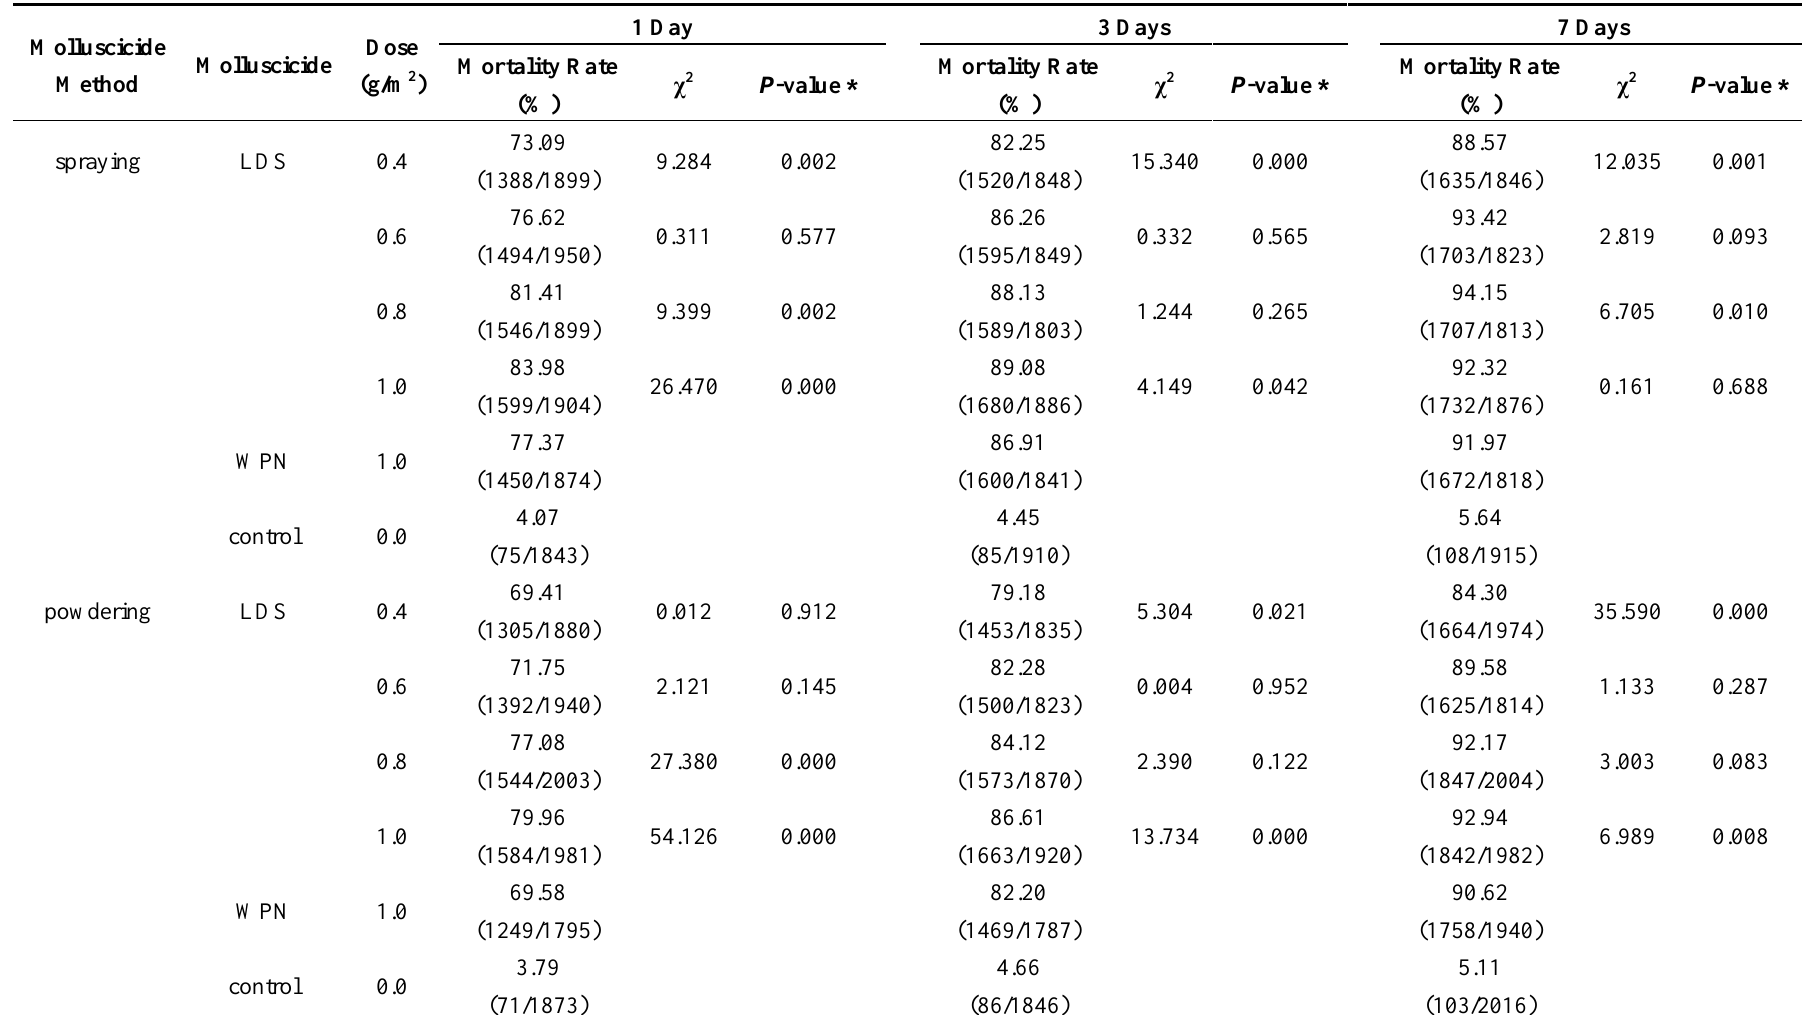
Table 2. Comparison of the mortality of snails exposed for 1, 3, or 7 days to different concentrations of LDS and WPN applied by spraying and powdering in 15 counties of Hubei